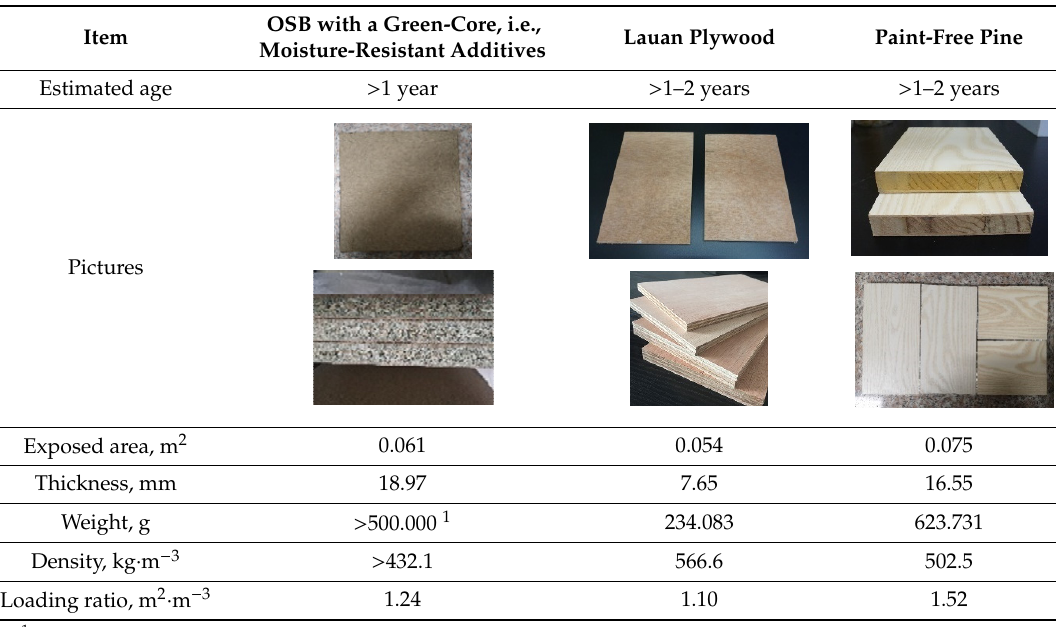
Table 1. Material information on the specimens of the three wood-based panels.